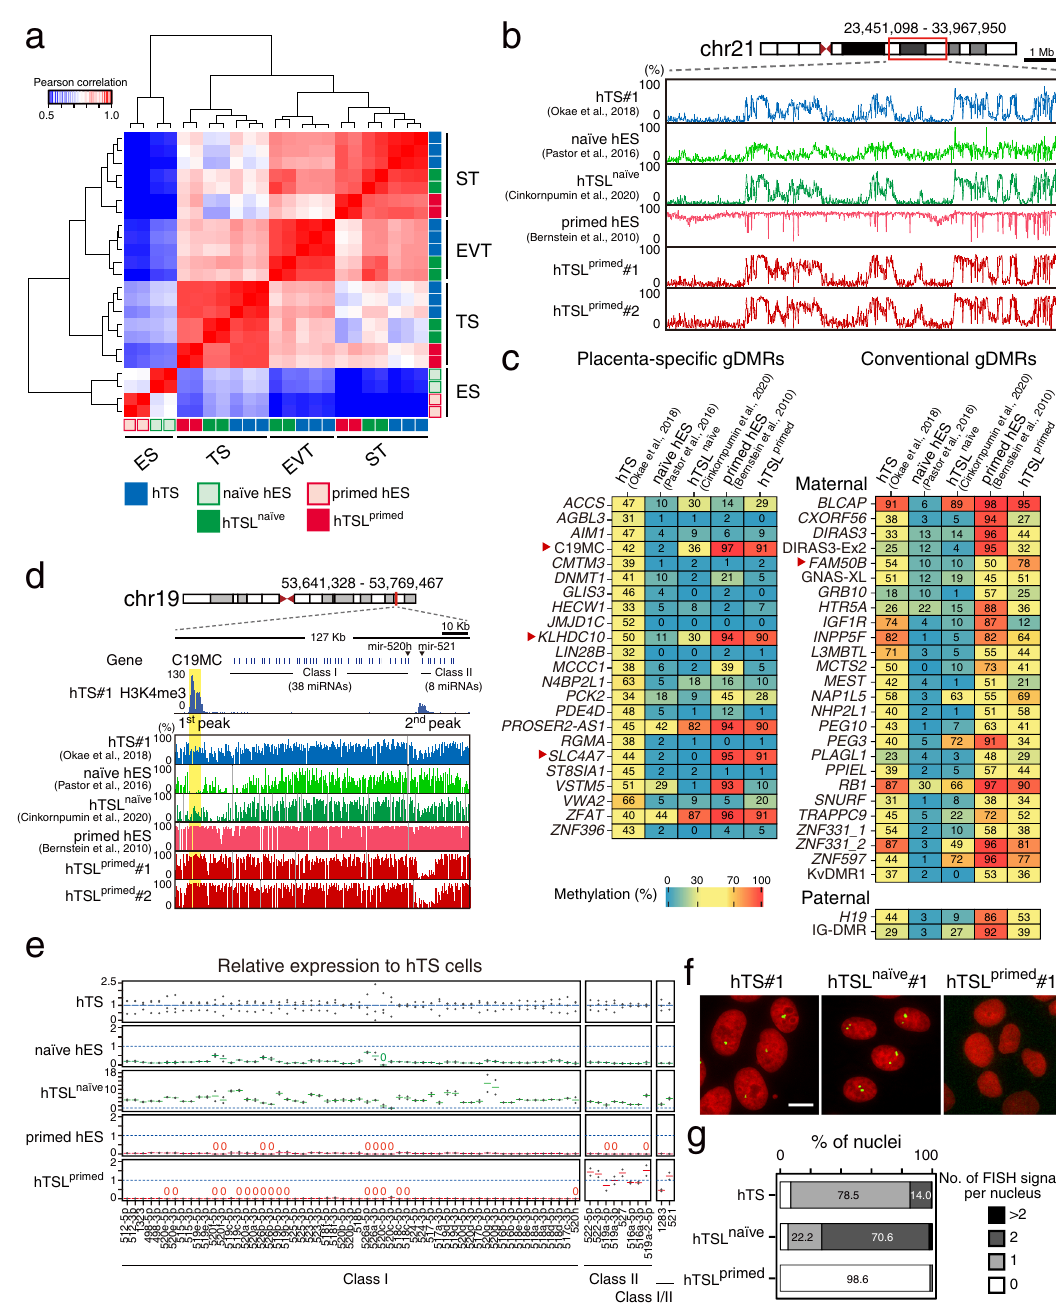
Fig. 3 Transcriptome and DNA methylome pro fi ling of hTSL cells. a Heatmap representation of Pearson correlation coef fi cients between hES, hTS, and hTSL cells and their differentiated derivatives. Only 8768 differentially expressed genes (TPM > 4 in at least one cell type, adjusted p -value < 0.05, fold change > 4) were analyzed. hES, hTS, and hTSL cells are color-coded as indicated. b DNA methylation patterns in hES, hTS, and hTSL cells. A part of chromosome 21 is indicated. c Heatmap representation of DNA methylation levels of gDMRs in hES, hTS, and hTSL cells. Heatmaps for placenta-speci fi c (left) and conventional (right) gDMRs are represented. All gDMRs, except for the H19 DMR and IG-DMR, are maternally methylated. Four gDMRs that were hypermethylated in hTSL primed cells but not in hTSL naïve and hTS cells are indicated by red arrowheads. d H3K4me3-enriched peaks and DNA methylation patterns at the C19MC locus. The C19MC DMR is highlighted in yellow. Vertical bars indicate methylation levels and gray indicates missing data or regions without CpG sites. Please see Supplementary Fig. 3b for the DNA methylation patterns of the C19MC DMR in hTSL naïve cells derived in this study. e Relative expression levels of C19MC miRNAs in hES, hTS, and hTSL cells. Expression levels in hTS cells are set as 1. Three hTS, two naïve hES, two hTSL naïve , two primed hES, and two hTSL primed cell lines were analyzed. Bar charts are shown as mean. Note that hsa-mir-1283 and -521 have copies in both the Class I and II regions. f RNA-FISH of C19MC in hTS and hTSL cells. C19MC expression was labeled with an Alexa Fluor 488-labeled oligonucleotide probe (shown in green). Nuclei were stained with Hoechst 33,258 (shown in red). The scale bar indicates 10 μ m. g Percentage of the number of C19MC FISH signals per nucleus in hTS and hTSL cells. Three hTS, two hTSL naïve , and two hTSL primed cell lines were analyzed, and the count data were summed up for each cell type. 500 – 1000 nuclei were examined. Nuclei in M-phase were excluded from the analysis. Publicly available WGBS data were used for hTS cells 6 , naïve hES cells 33 , hTSL naïve cells 15 , and primed hES cells 34